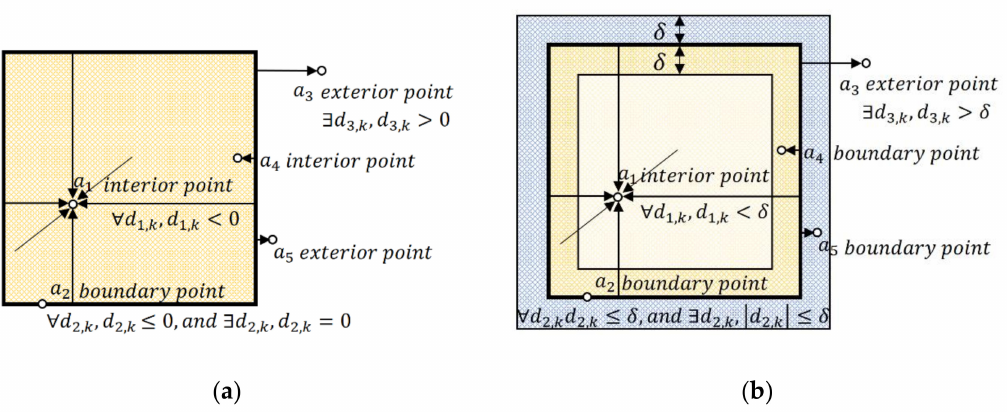
Figure 4. The classification method of point a i . ( a ) Classical method; ( b ) Our method with the deviation factor δ . The directed distance d i , k is presented by the arrow from the face k of convex hull to the point → a i . If d i , k and n k are in the same direction, then d i , k > 0, otherwise d i , k <